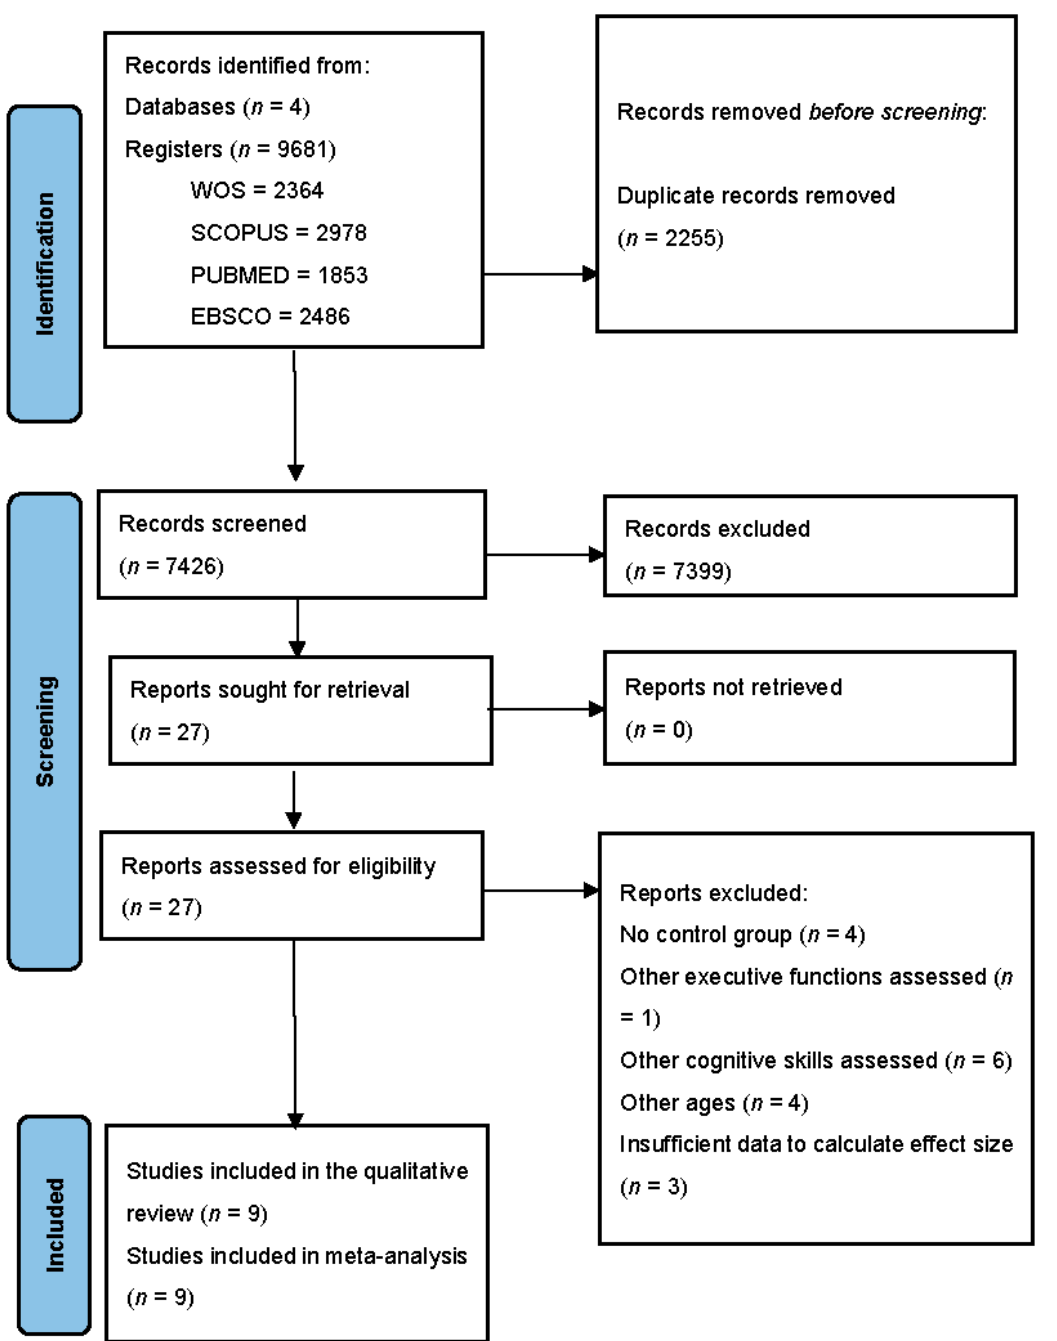
Figure 1. A flow diagram of the studies included in the meta-analysis.